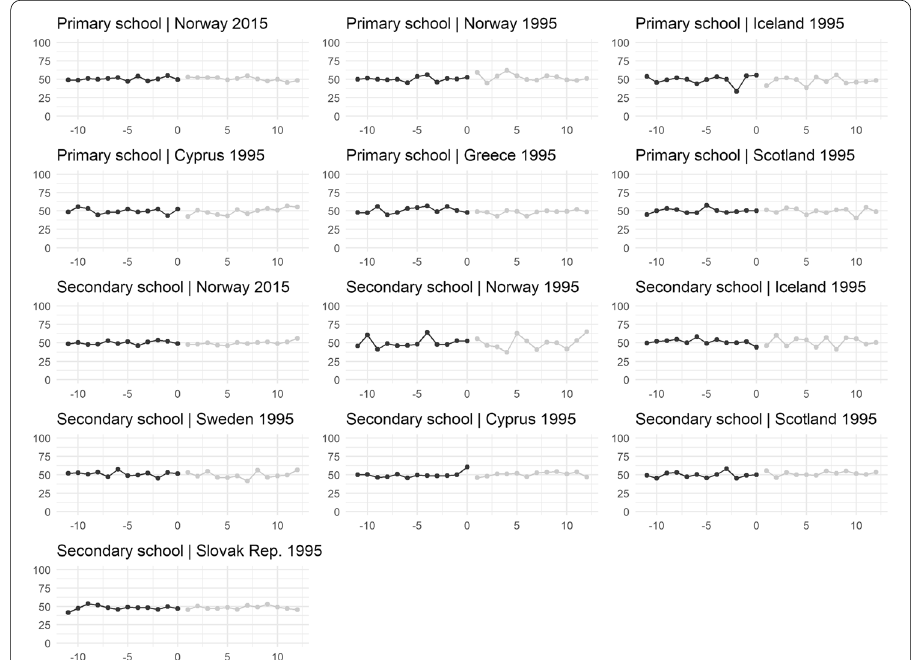
Fig. 5 Percent of boys by age in months in the 13 samples. The x-axis depicts the age in months and the y-axis depicts the percentage of boys. The black dots indicate lower grade students and the grey dots upper grade